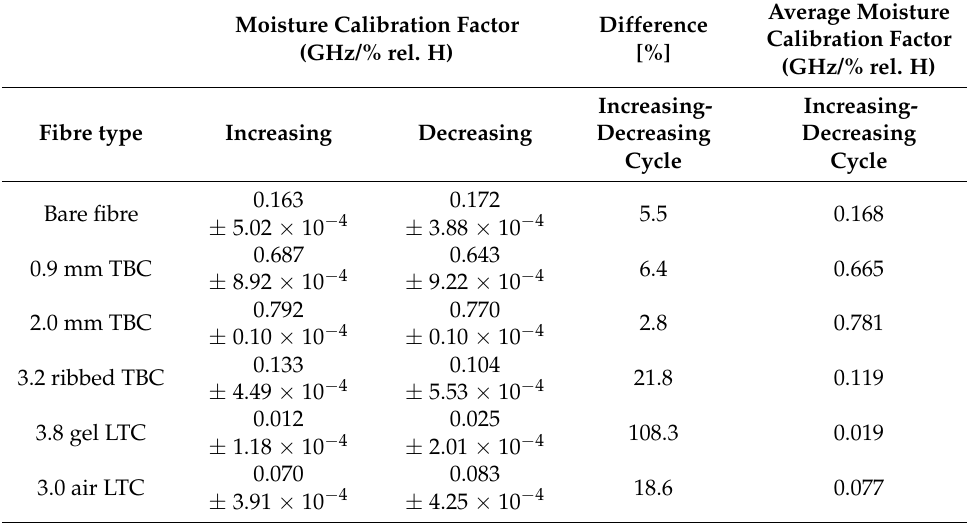
Moisture Calibration Factor (GHz/% rel. H)